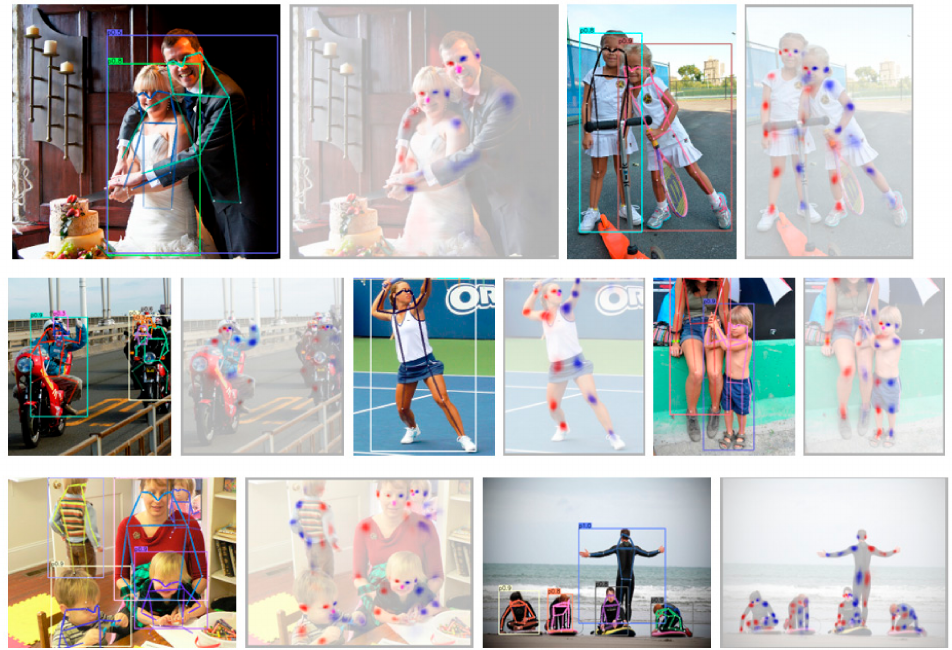
Figure 5. Qualitative results on the MSCOCO dataset. For each pair, we show the predicted human pose ( left ) and intermediate heatmap ( right ). In the predicted human pose, each color corresponds to a particular human